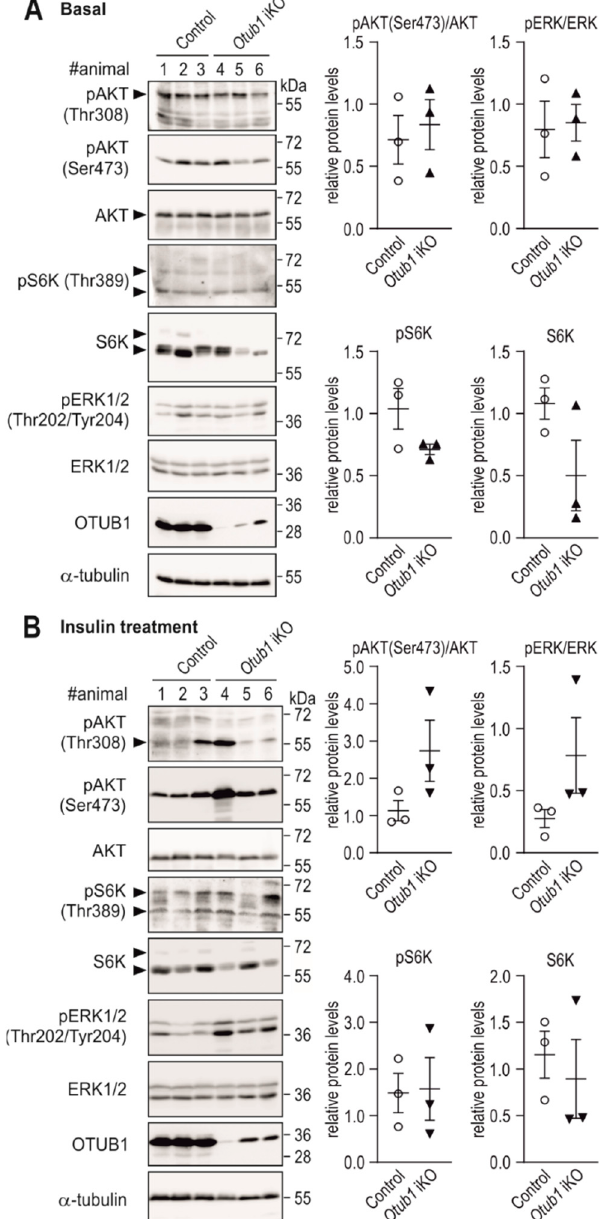
Figure 5. Basal and stimulated insulin receptor-dependent signaling in the liver with induced Otub1 deletion. ( A ) Immunoblotting and quantification (normalized to loading control and the indicated proteins) of liver lysates from the mice shown in Figure 4C ( n = 3). ( B ) Immunoblotting and quantification (normalized to loading control and the indicated proteins) of liver lysates from mice (10 days after Otub1 KO; 2-month-old mice; n = 3) starved overnight (16 h) followed by intraperitoneal insulin application (0.75 mU insulin/g) 15 min prior to tissue harvest. #animal, animal number. ( A , B ) For pS6K, S6K, pERK1/2 and ERK1/2, both indicated immunoblot signals were quantified for the depicted quantification results. Full-length immunoblots are shown in Figures S7 and S8.